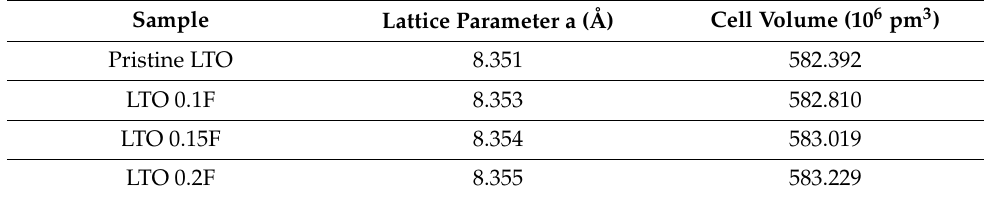
Table 1. Lattice parameter and cell volume for all LTO samples.